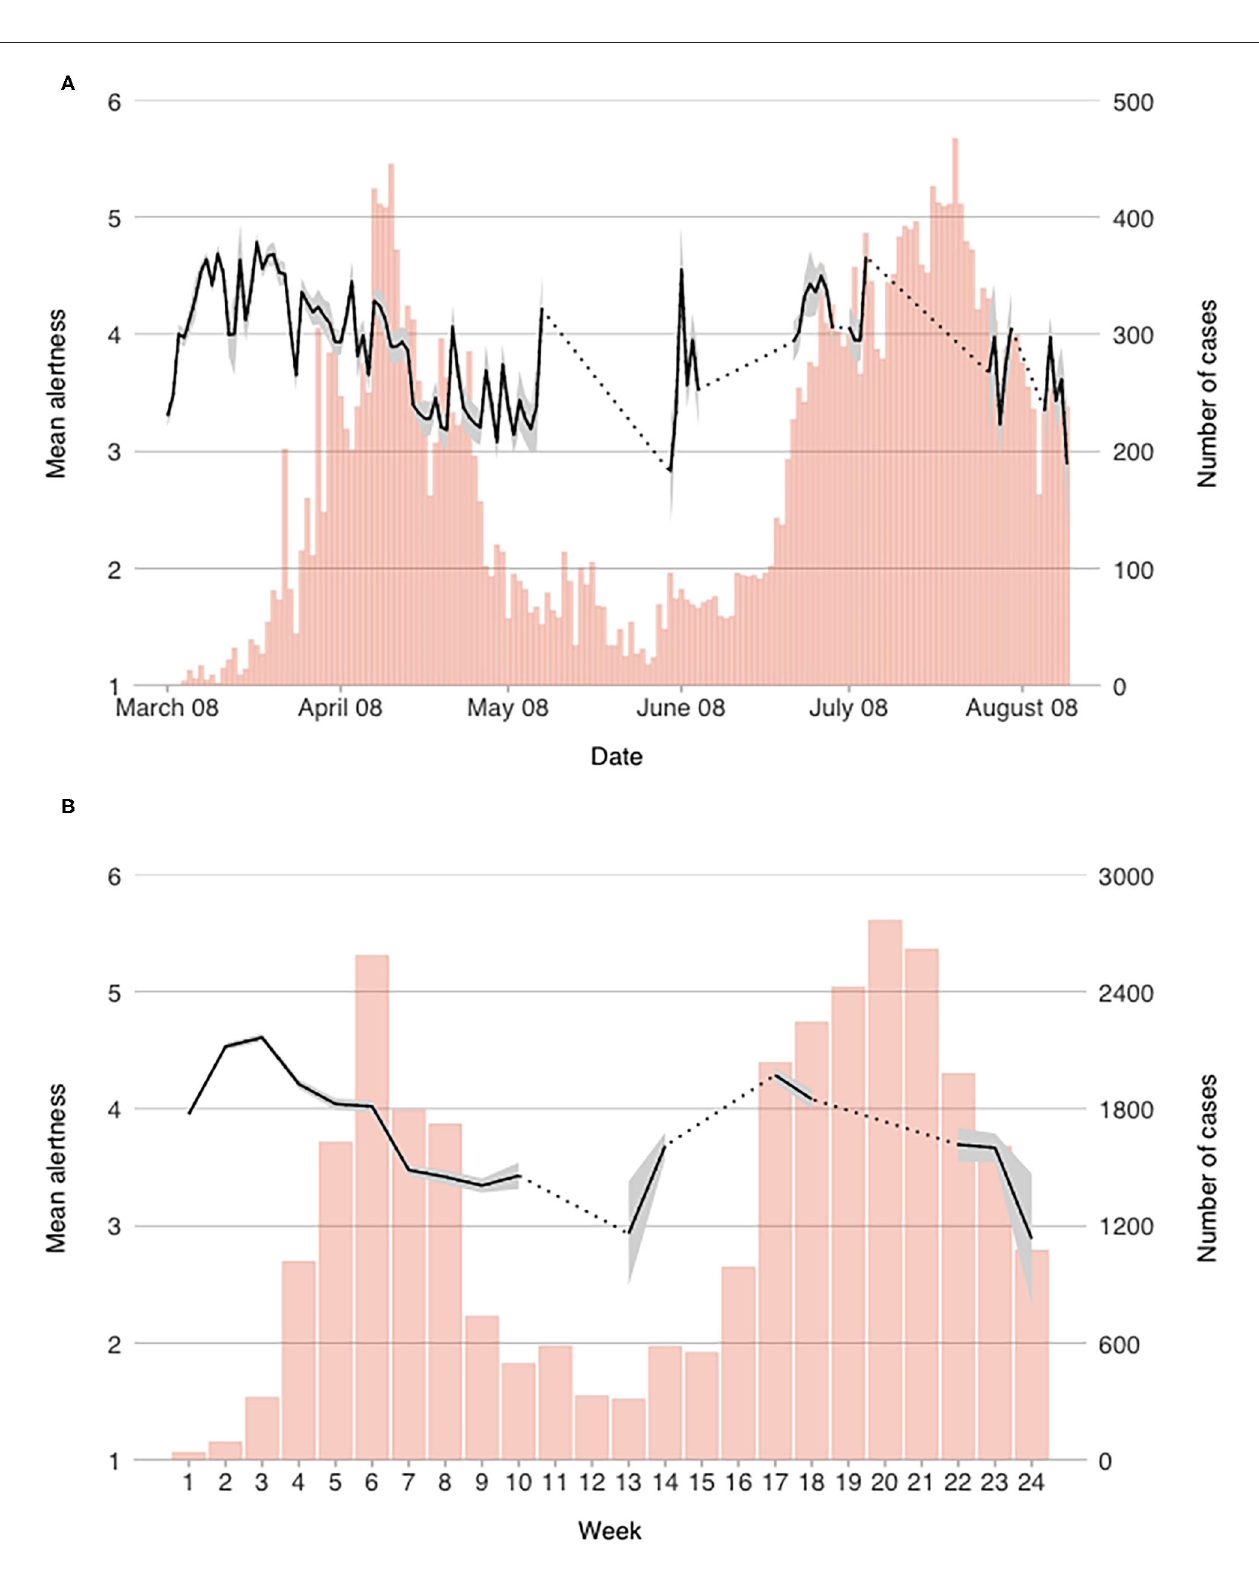
FIGURE 2 | Mean alertness scores on a (A) daily, and (B) weekly level.